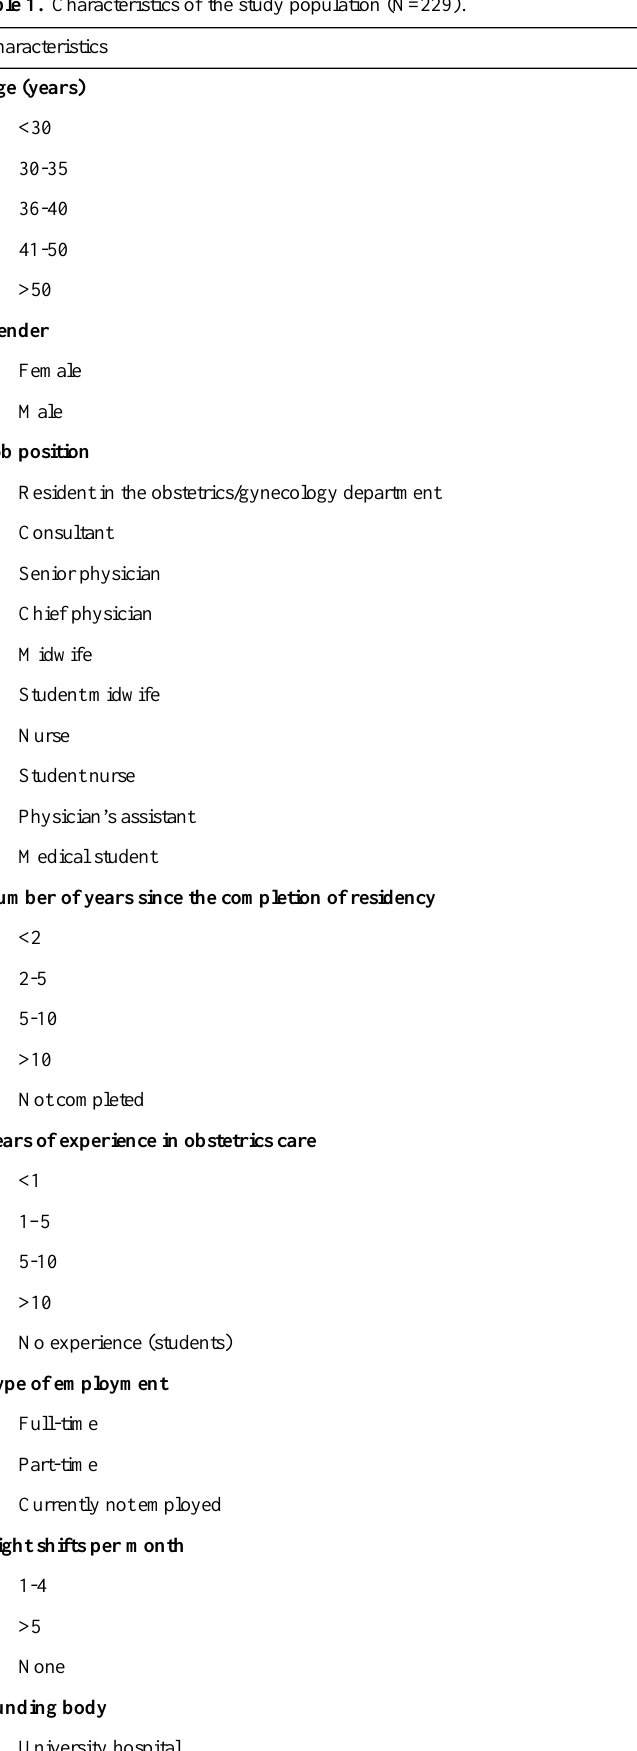
Table 1. Characteristics of the study population